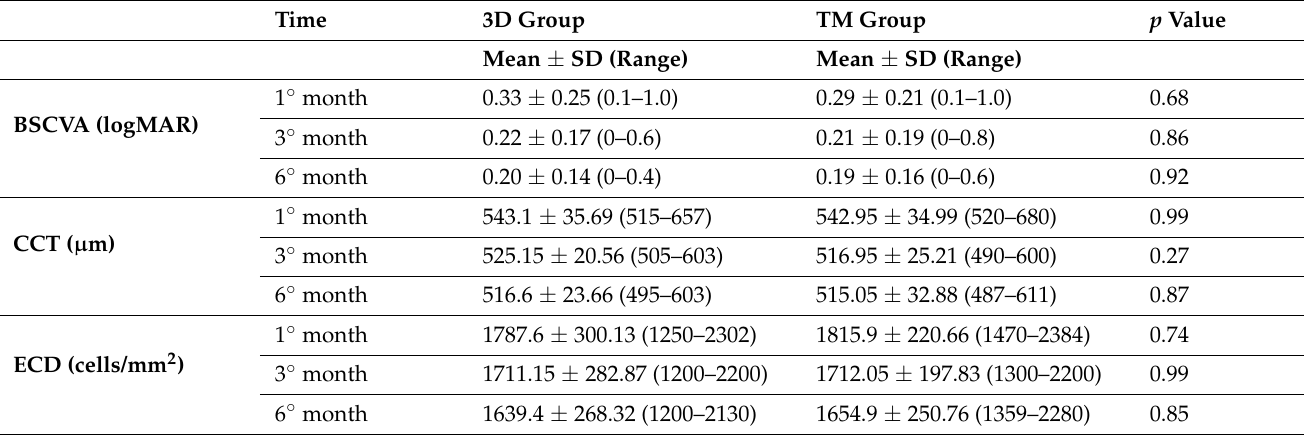
Table 4. Patient postoperative clinical